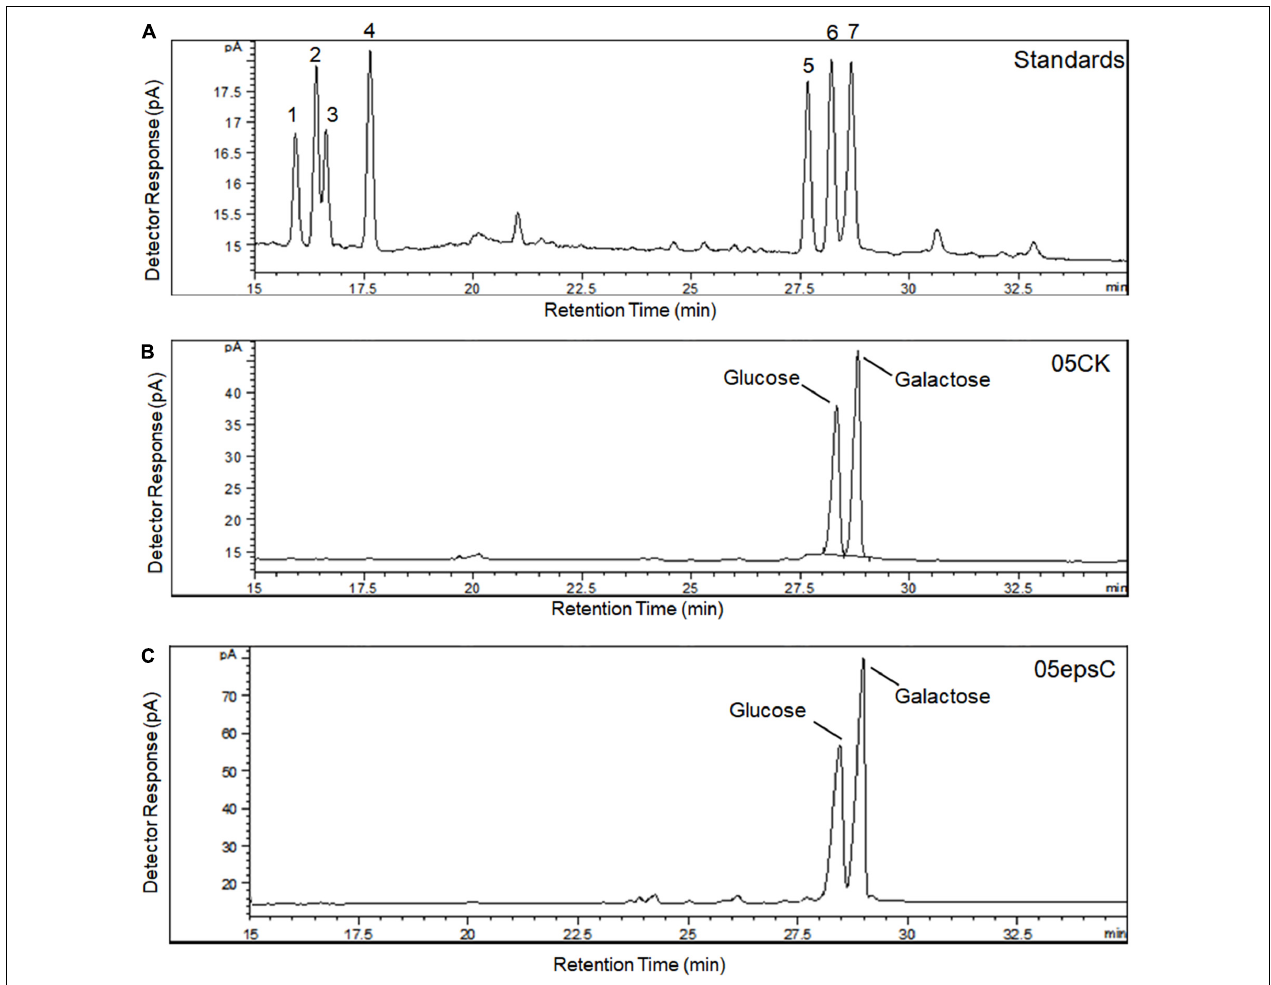
FIGURE 2 | Monosaccharide composition of hydrolyzed EPS from S. thermophilus 05epsC and 05CK by GC-MS analysis. (A) Monosaccharide standards: (1) rhamnose; (2) fucose; (3) arabinose; (4) xylose; (5) mannose; (6) glucose; (7) galactose. (B) Hydrolyzed EPS from S. thermophilus 05CK. (C) Hydrolyzed EPS from S. thermophilus